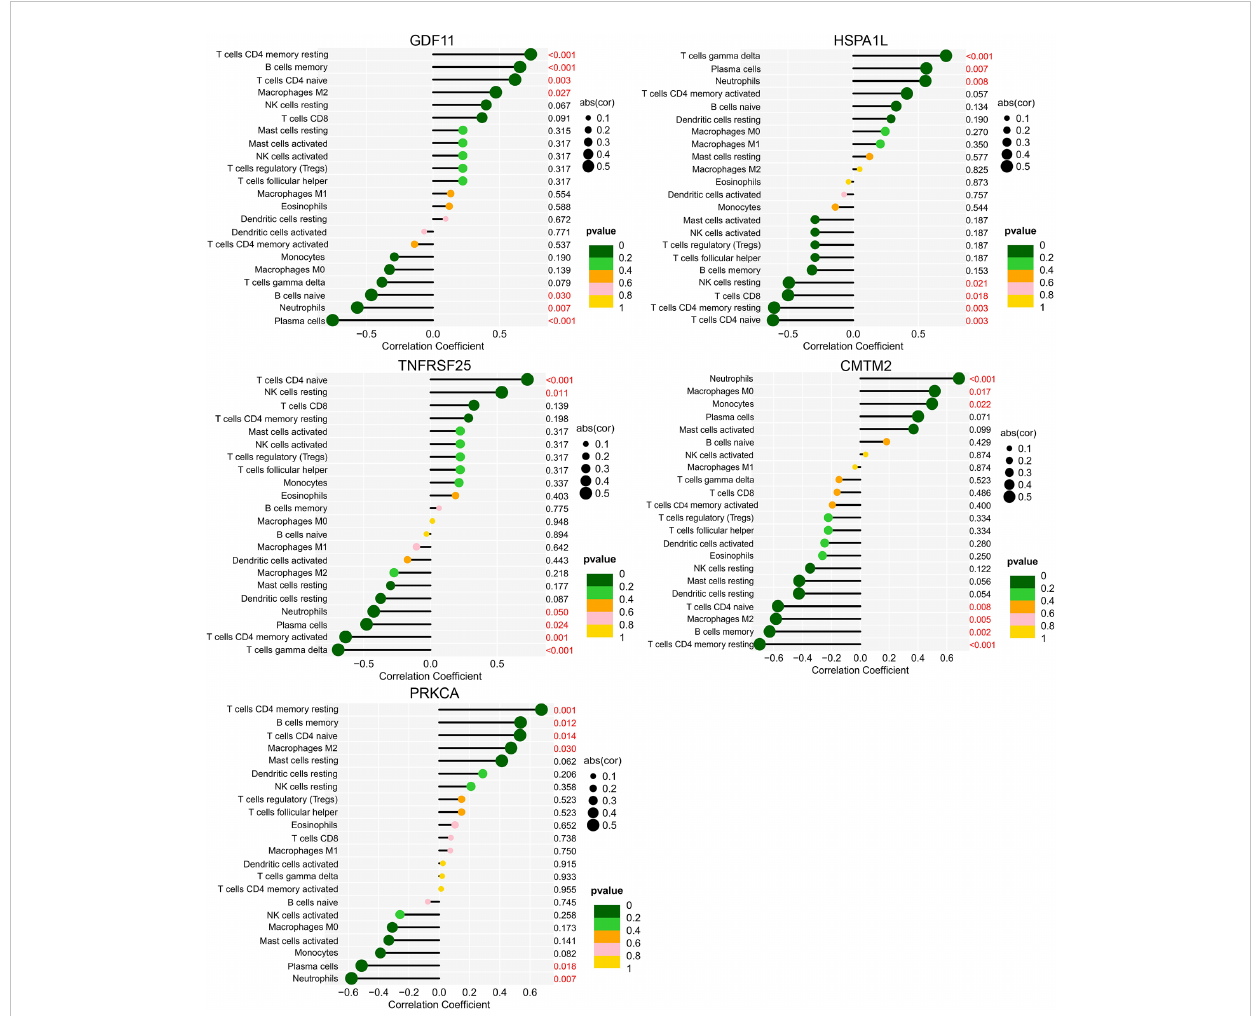
FIGURE 14 Correlation between biomarkers and immune cells of the AIS A and AIS D grades of SCI. The ordinate on the left represents the proportion of innate immune cells, the ordinate on the right represents the P value of the correlation test, and the abscissa represents the correlation coef fi cient. The size of the circle represents the correlation coef fi cient, and the color of the circle represents the P value of the correlation test; a P value<0.05 was considered statistically signi fi cant. SCI, Spinal cord injury; AIS, American Spinal Cord Injury Association Impairment